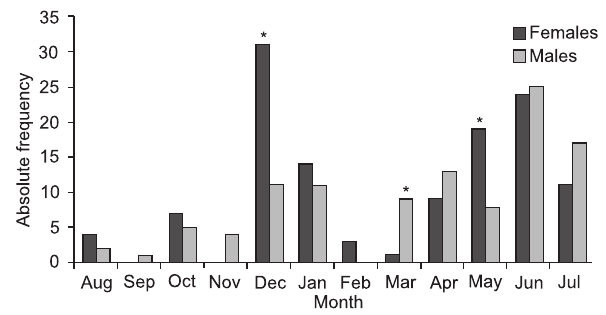
Figure 2. Distribution of S . herzbergii by sex between August 2009 and July 2010 in Paraíba do Norte River Estuary, Brazil. * Months in which sex ratio differed significantly from 1:1 (p <